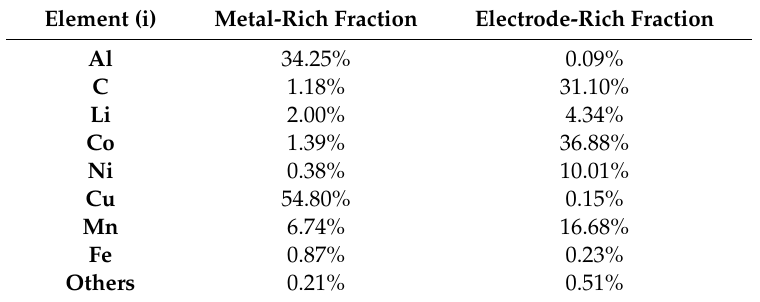
Table 2. Recovered wt% of the pre-processing steps reported in the literature [9,21].